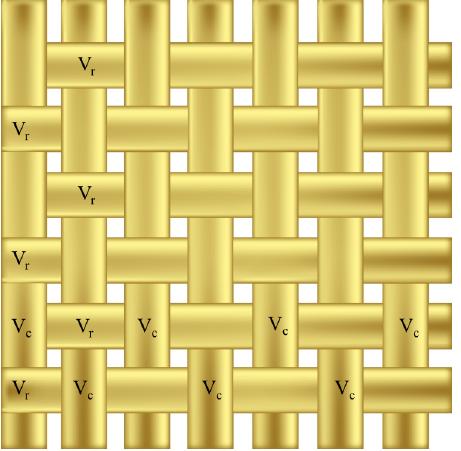
Figure 1. Schematic diagram representing the principle of interlacing the various stripes of conductors. The figure does not represent the operating procedure that was used to actually “intertwine” the conductors but only the final arrangement. The insulator bands are not